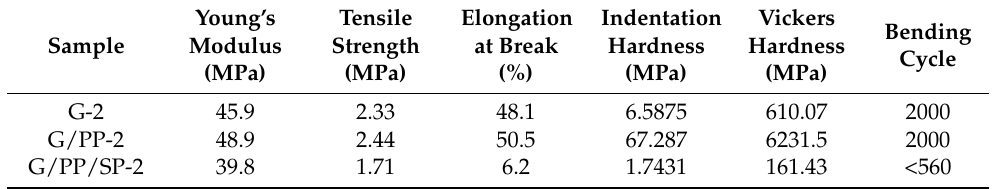
Table 3. Mechanical properties of edible